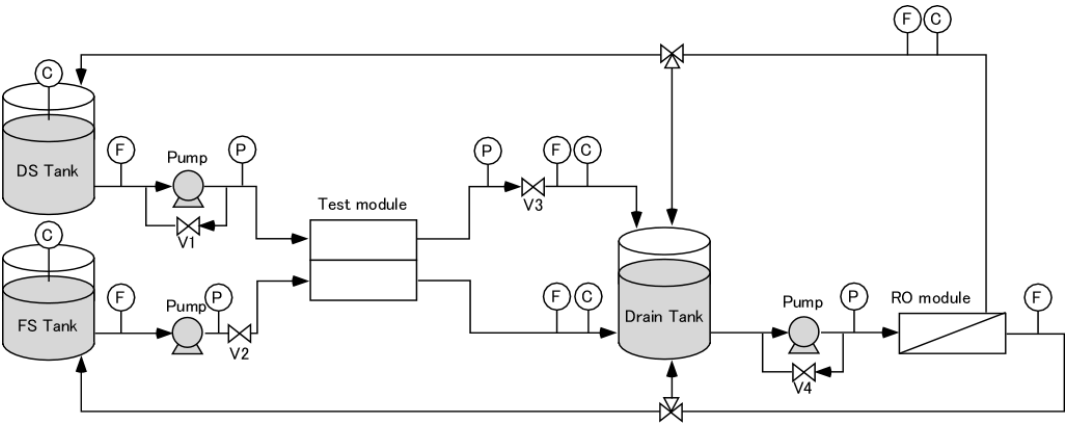
Figure 1. A schematic diagram of the bench-scale pressure-retarded osmosis (PRO) evaluation system. The character inside the circles denote the following: C, conductivity meter; F, flow meter; P, pressure gauge.